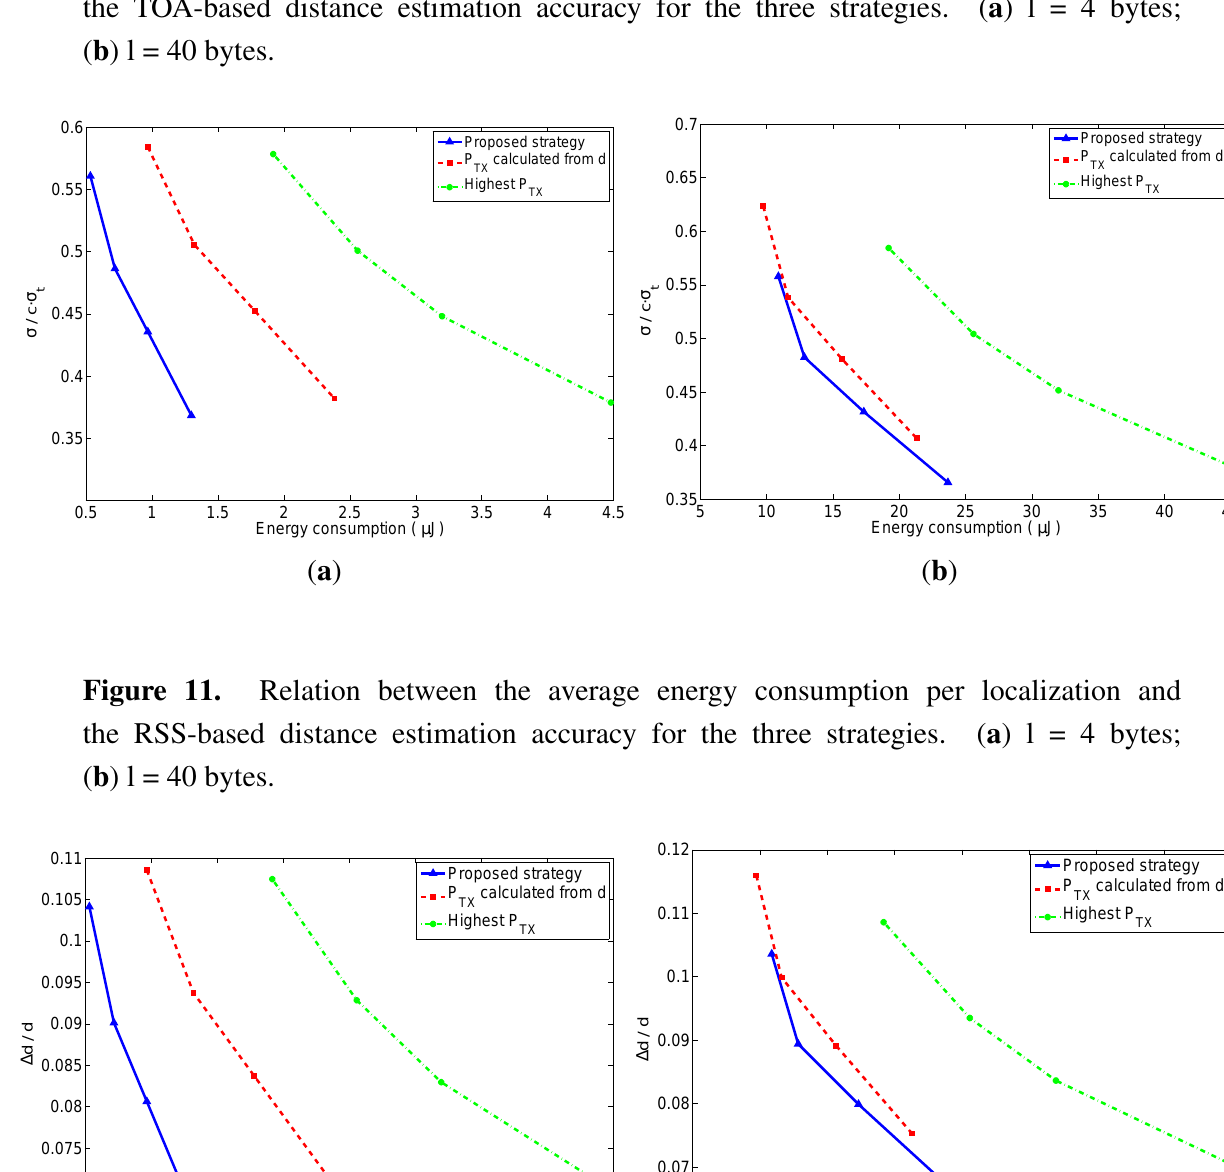
Figure 10. Relation between the average energy consumption per localization and the TOA-based distance estimation accuracy for the three strategies.